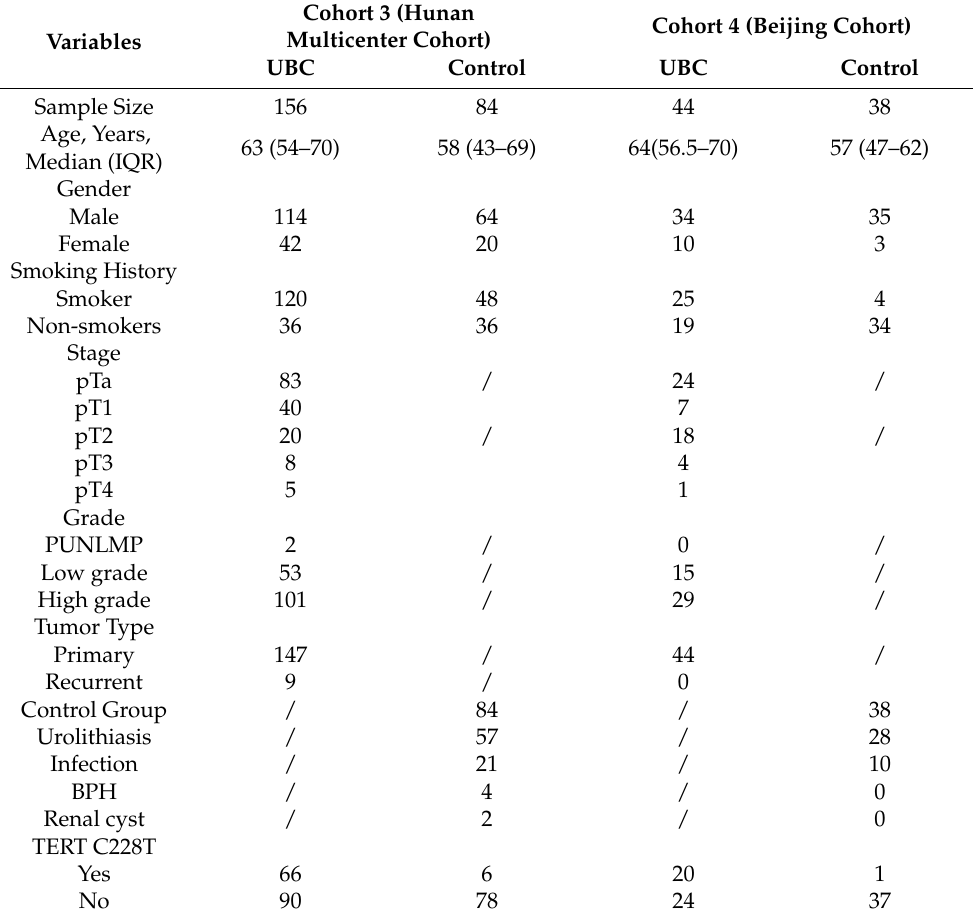
Table 1. Clinical and pathological data of the